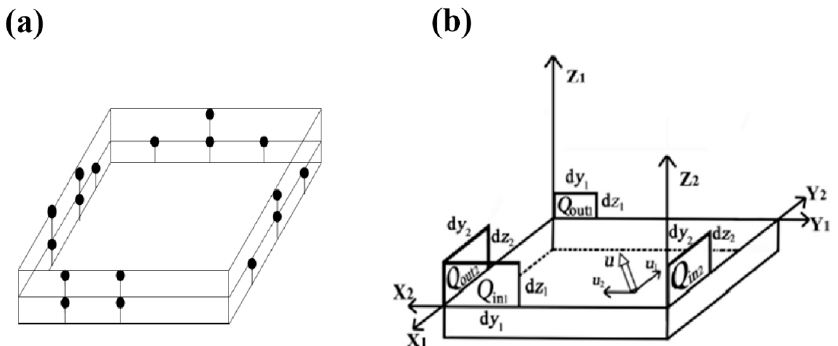
Figure 5. Schematic diagram of ( a ) test point layout and ( b ) calculation